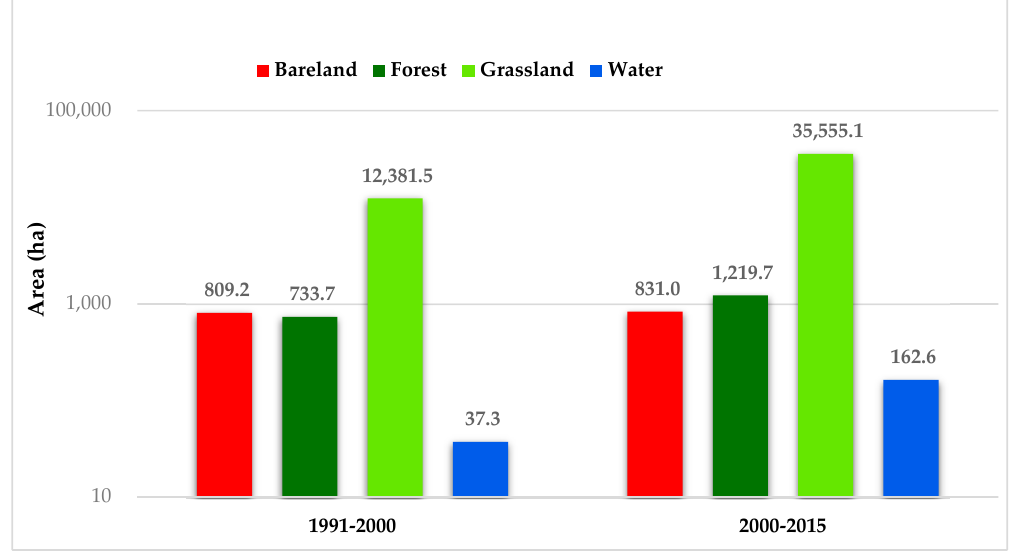
Figure 5. Net gains and losses that are associated with built-up during the two study periods. The statistics also revealed a massive decrease in forest areas in the region. Between 1991 and 2000, about 20,121 ha, which translates into 37.1% of the forest cover in 1991, was lost. Out of the total forest lost during this period, about 19,300 ha. was transformed into grassland. The statistics further indicated that the forest cover in the region continued to immensely diminish between 2000 and 2015, with the majority of the forested areas being converted into grassland during this period as well. From 2000 to 2015, about 23,790 ha. of the forest cover in GAMA was lost, representing a net loss of 69.7%. Accounting for this loss, about 22,296 ha. of forested areas were converted into grassland, which represents 93.7% of the total forest lost between 2000 and 2015. Approximately 1220 ha. of the forest lost were also transformed into built up areas, contributing to the massive urban expansion going on in the region.